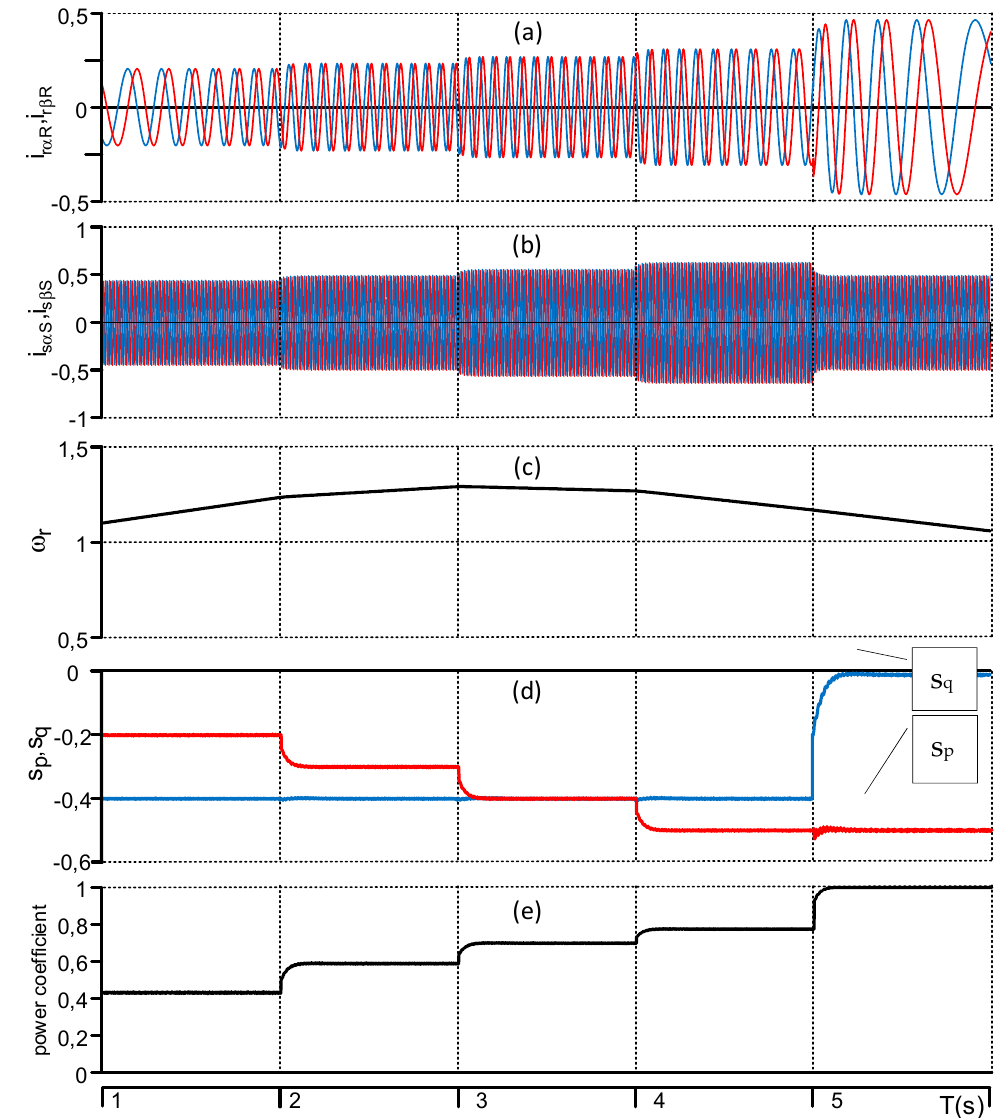
Figure 8. DFIG system behavior during changes of the active and reactive powers with constant driven torque. ( a ) Rotor current vector components; ( b ) stator current vector components; ( c ) rotor speed; ( d ) active and reactive powers; ( e ) power factor.